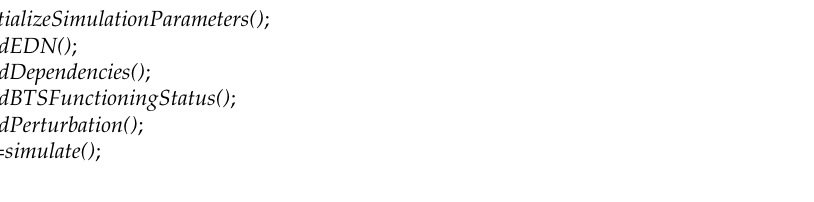
Figure A1. The RecSim